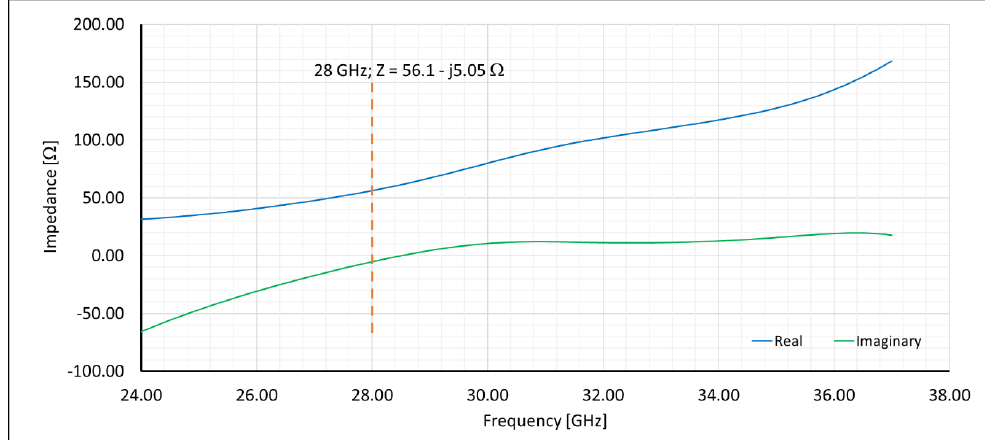
Figure 7. The chart of the complex input impedance as a function of frequency for the proposed antenna working in the 5G system (real part, blue line and imaginary part, green line).